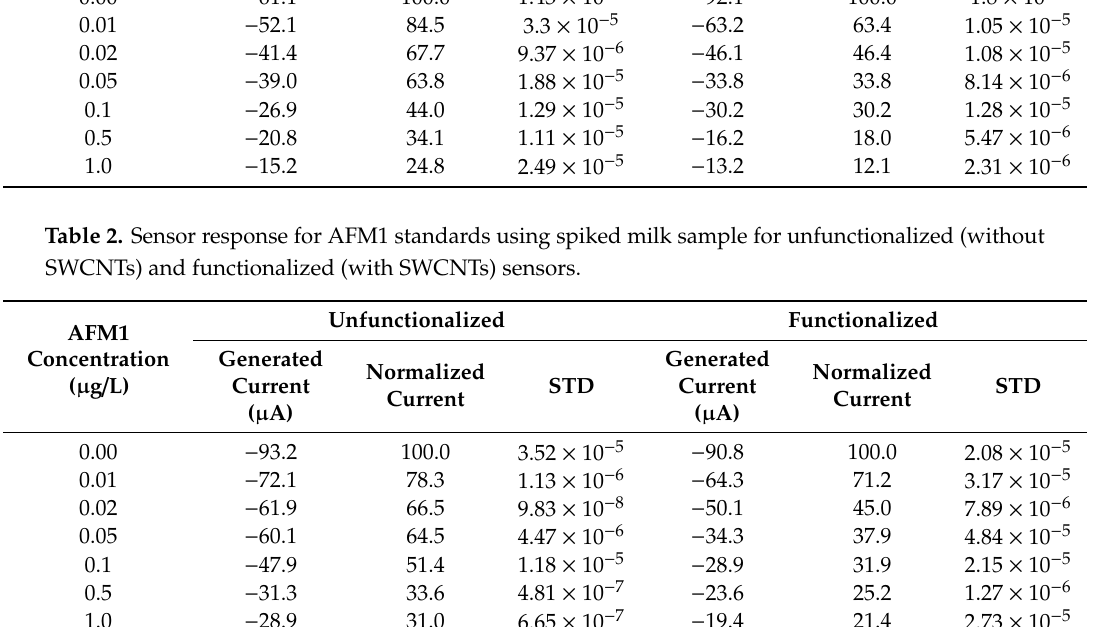
Table 1. Sensor response for AFM1 standards using phosphate-bu ff ered saline (PBS) solution for unfunctionalized (without SWCNTs) and functionalized (with SWCNTs) sensors. AFM1 Concentration